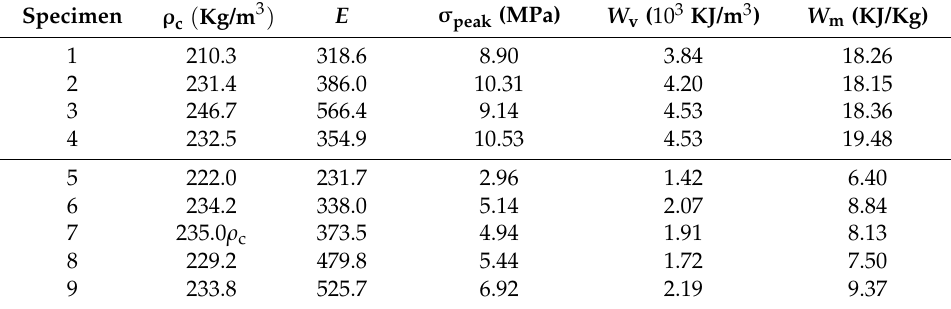
Figure 7. Normal PMI foam-based specimen images after compression. ( a ) PMI foam; ( b ) Tube-enhanced PMI foam; ( c ) Foam-filled tube-enhanced PMI foam; ( d ) Layer-by-layer buckling deformation of metallic tube in tube-enhanced PMI foam. Table 2. Summary of the averaged elastic modulus E , compressive strength σ peak , and energy absorption per unit volume W v and per unit mass W m of the specimens as well as density ρ c .